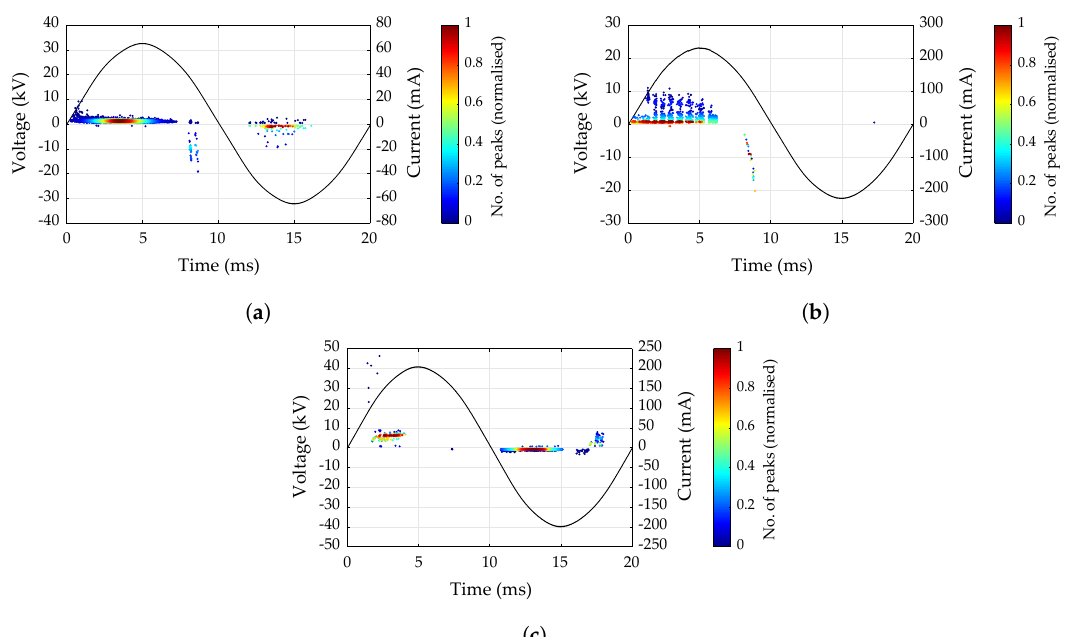
Figure 15. Current peaks densities for 6mm thickness insulator samples: ( a ) PTFE in CO 2 at 1bar absolute pressure, ( b ) epoxy resin in N 2 at 1bar absolute pressure and ( c ) silicone rubber in dry air at 1bar absolute